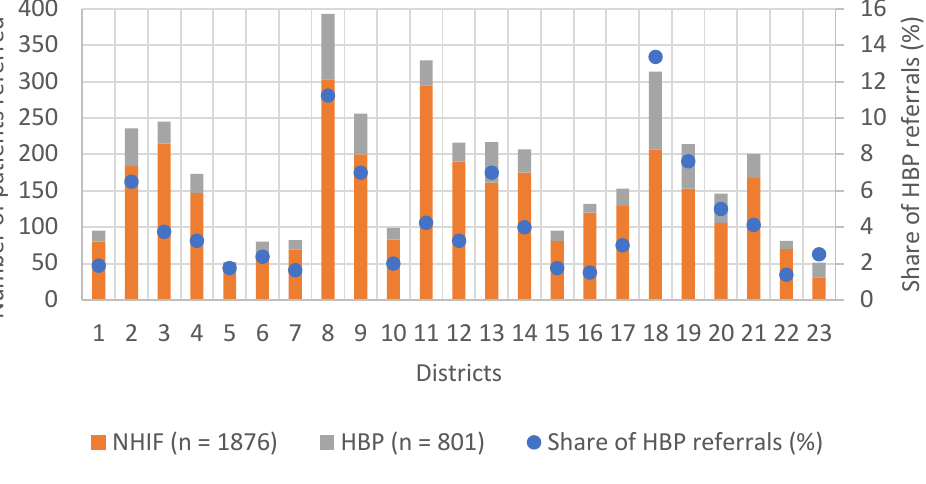
Figure 2. Share of patient referrals by 23 districts in Budapest.